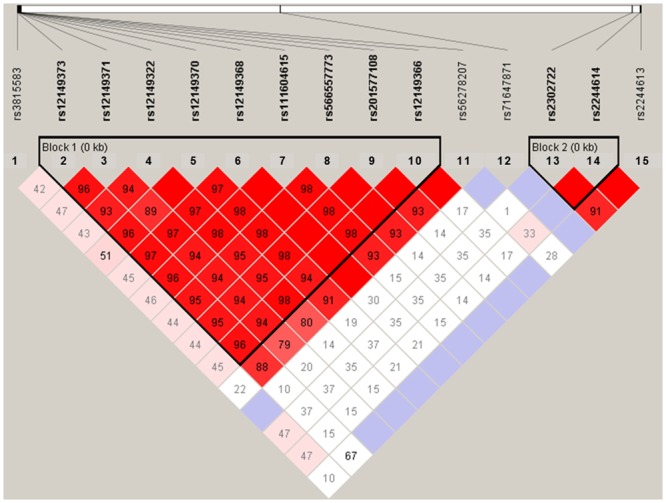
Linkage disequilibrium (LD) relationships between single nucleotide polymorphisms (SNPs) of CES1A1.The top of the figure shows SNPs and the bottom of the figure shows LD relationships as well as LD blocks of highly coupled variants. The strength of LD was determined by R2 statistics.